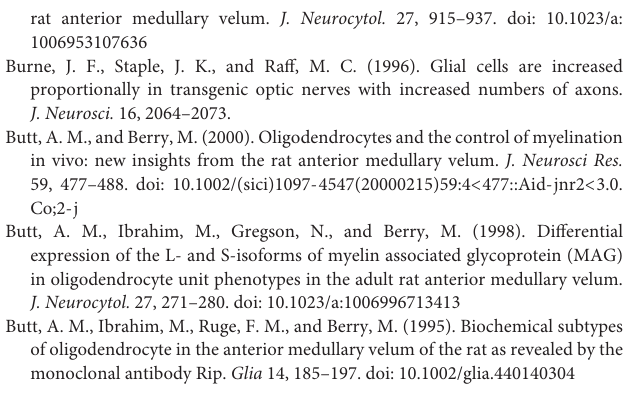
Supplementary Figure 1 | Expression pattern of ITPR2 in the spinal cord. (A–F) Itpr2 ISH in mouse spinal cord from E18.5 to P30. Scale bar represents 25 µ m. Black arrows highlight Itpr2 + cells. (G–J) ITPR2 double immunofluorescence with anti-OLIG2, anti-CC1 or anti- NeuN in P4, and P7 spinal cord sections. ITPR2 positive cells are mostly co-labeled with OLIG2 and CC1 (white arrows), but not with anti-NeuN. Scale bar represents 50 µ m. Supplementary Figure 2 | Expression of Itpr2 in Nkx2. 2- cKO (A,B) and Myrf - cKO. (C,D) Mutant spinal cords is dramatically reduced at P3 stages. Scale bar represents 100 µ m. Supplementary Figure 3 | Disruption of Itpr2 has no effect on Itpr1 and Itpr3 expression in the white matter. Spinal cord tissues from P3 (A–D) and P7 (E–H) wild-type and Itpr2 − / − mice were examined for expression of Itpr1 and Itpr3 by ISH. Scale bar represents 100 µ m. Supplementary Figure 4 | ITPR2 deletion produces no difference to the astrocytes in the corpus callosum and neurons in the cortex. Brain tissues from P15 wild-type and Itpr2 knockout mice were immunostaining with astrocyte marker GFAP (A,B) and neuron marker NeuN (C,D) . Scale bar represents 50 µ m. Supplementary Figure 5 | Analyses of the number of myelinated axons in the corpus callosum (A) and optic nerves (B) from wild-type and Itpr2-/– mice. Error bar indicates Means ± SEM. n ≥